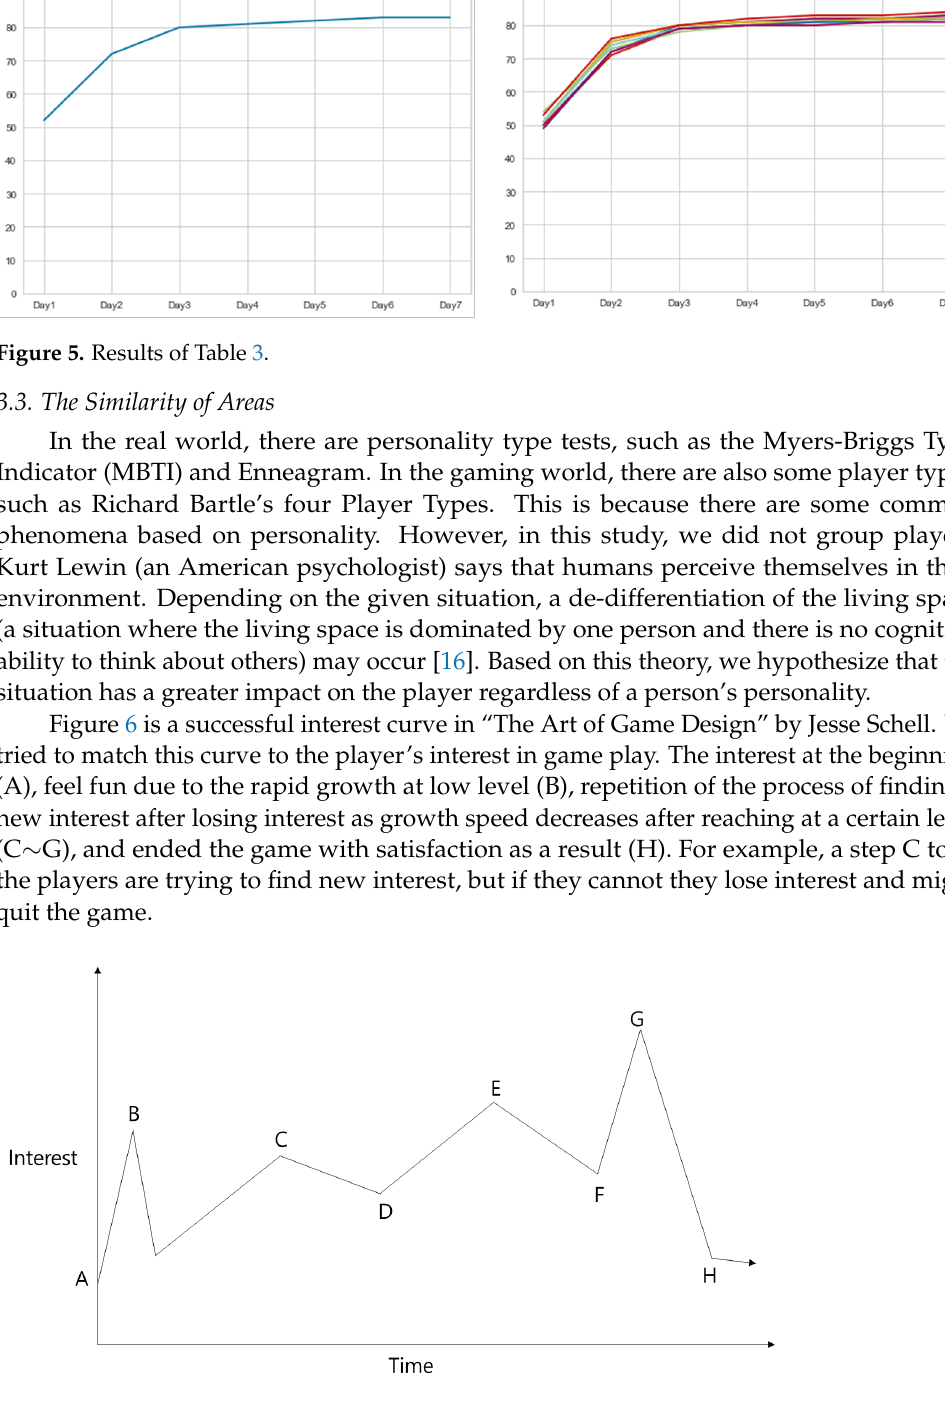
Figure 6. A successful interest curve